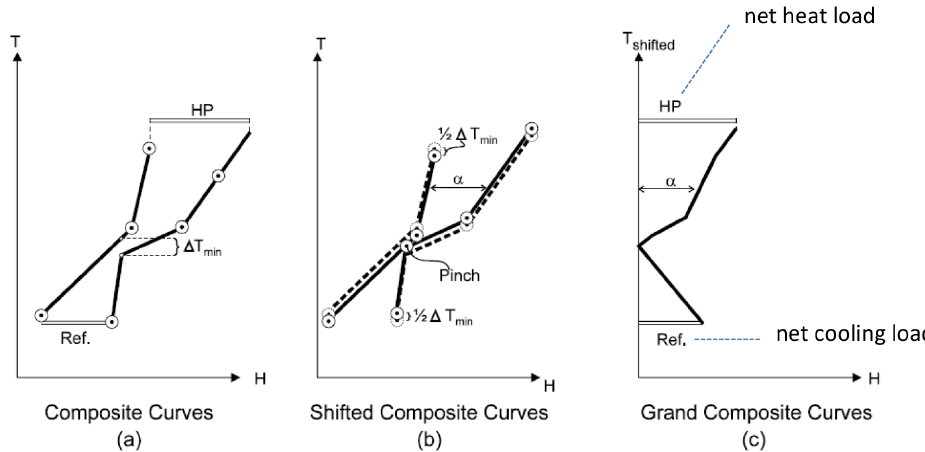
Fig. 33. – Construction of the grand composite curve